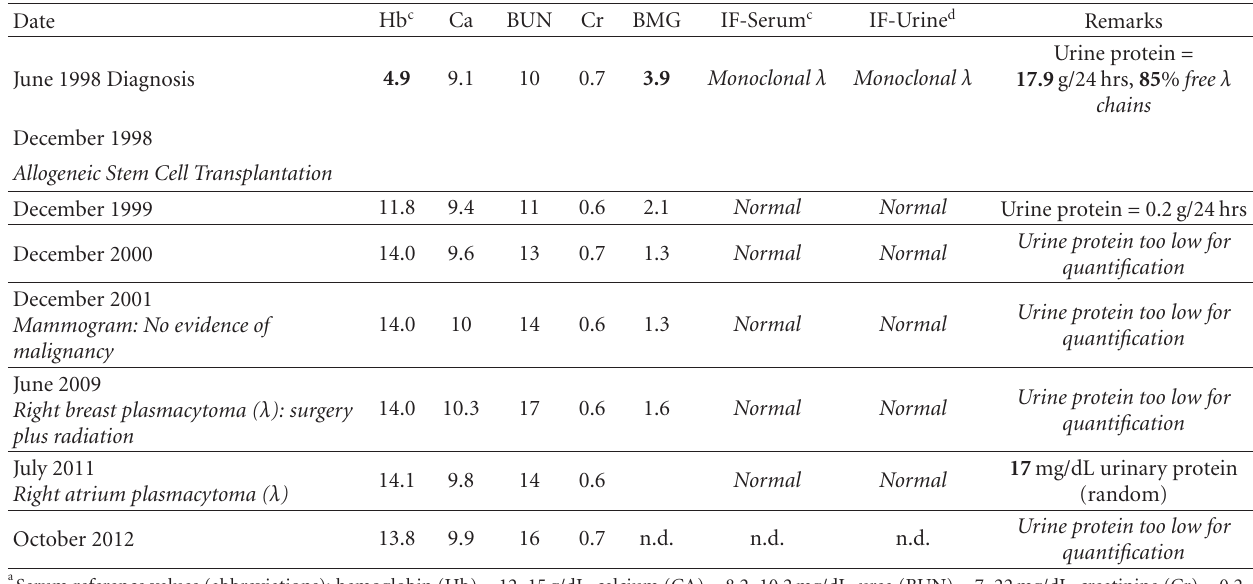
Table 1: Summary of laboratory tests a,b .